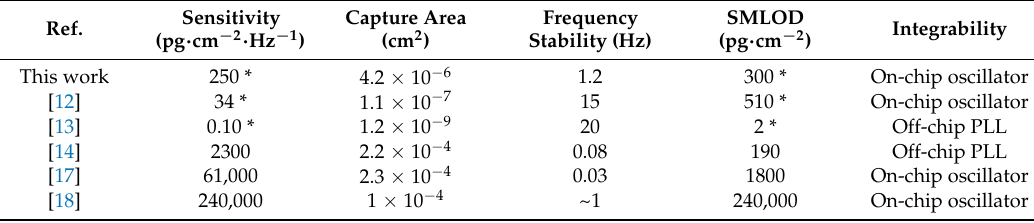
Table 2. State-of-the-art of CMOS-MEMS resonators as distributed mass sensors operating in air conditions.